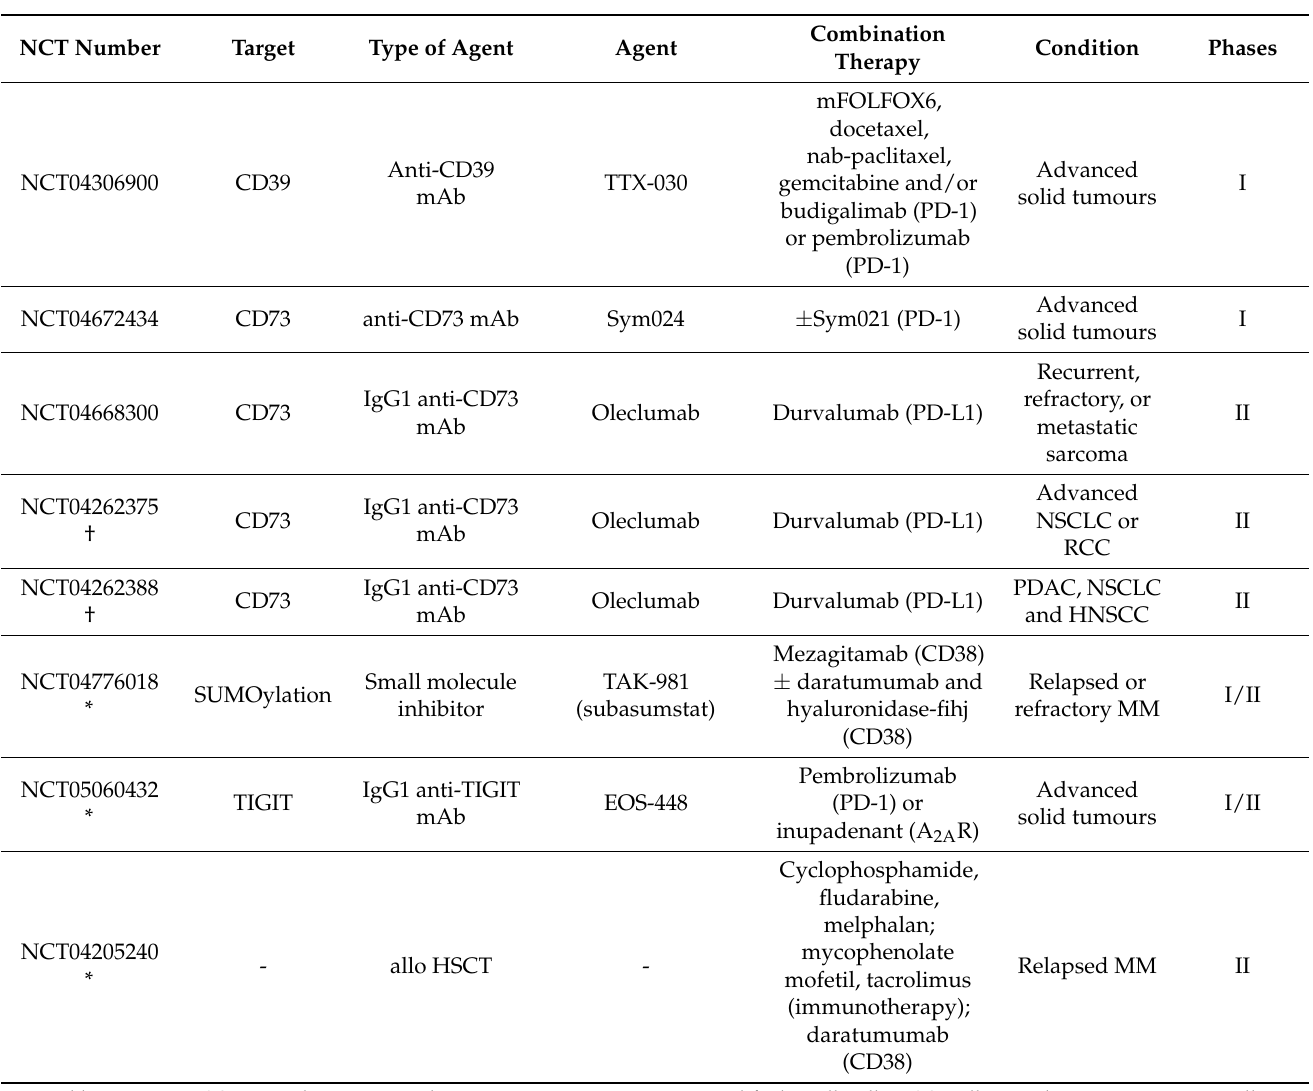
Abbreviations: 4SCAR-T, 4th generation chimeric antigen receptor gene-modified T cells; allo HSCT, allogenic hematopoietic stem cell transplantation; BCMA, B cell maturation antigen; BTK, Bruton’s tyrosine kinase; CAR-T, chimeric antigen receptor T cells; CRC, colorectal cancer; DA-EPOCH, dose-adjusted etoposide, prednisone, vincristine sulfate, cyclophosphamide, and doxorubicin hydrochloride; ETB, engineered toxin body; HNSCC, head and neck squamous cell carcinomas; MM, multiple myeloma; mAb, monoclonal antibody; NK, natural killer; NSCLC, non-small cell lung cancer; PD-1, programmed cell death protein 1; PD-L1, programmed cell death protein ligand 1; PDAC, pancreatic ductal adenocarcinoma; RCC, renal cell carcinoma; TIGIT, T cell immunoreceptor with Ig and ITIM